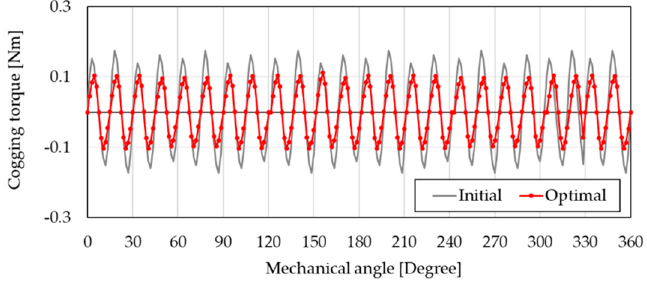
Figure 16. Comparison of the experimental cogging torque characteristics.